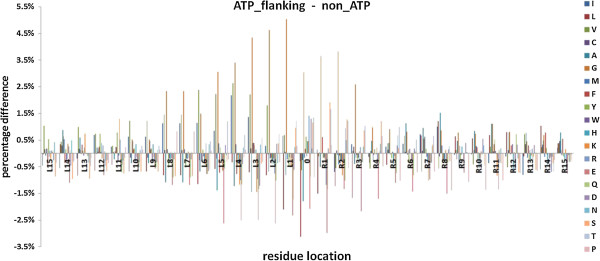
Differences with respect to amino acids composition between AIRs and non-AIRs. The values at position 0 on the horizontal axis mean the values for AIRs, L means the left flanking side and R means the right flanking side.